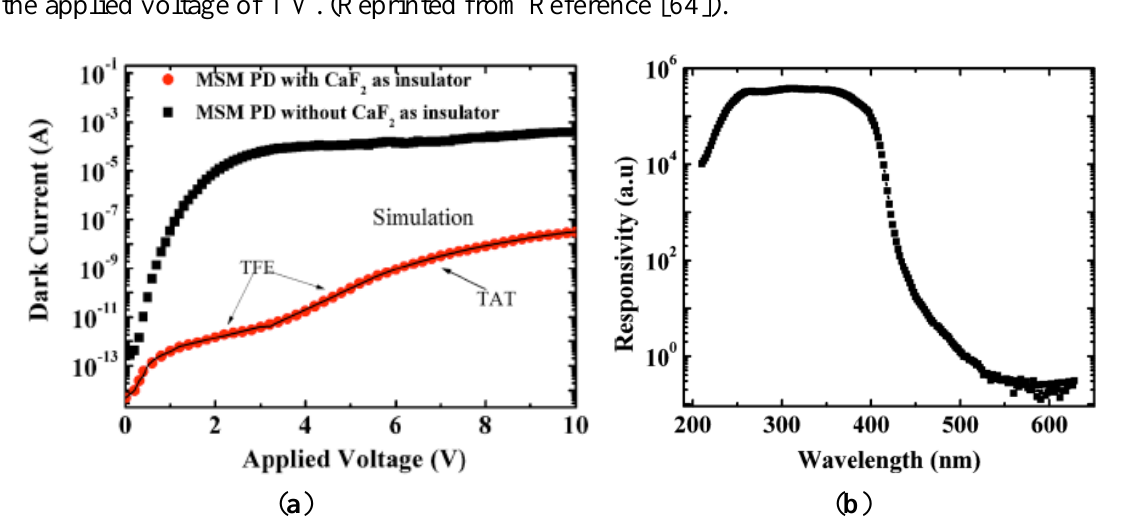
Figure 5. ( a ) The typical dark I-V characteristics for MSM photodetector without and with CaF insulator; ( b ) Photocurrent spectra measured under the illumination of xenon lamp at 2 the applied voltage of 1 V. (Reprinted from Reference